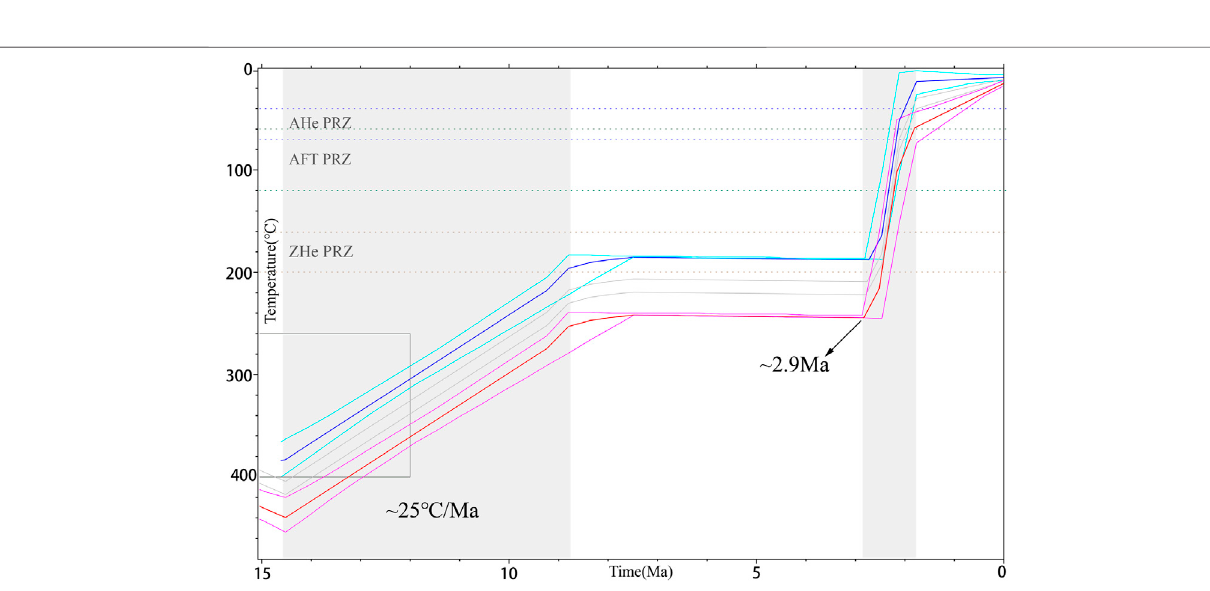
Frontiers in Earth Science |